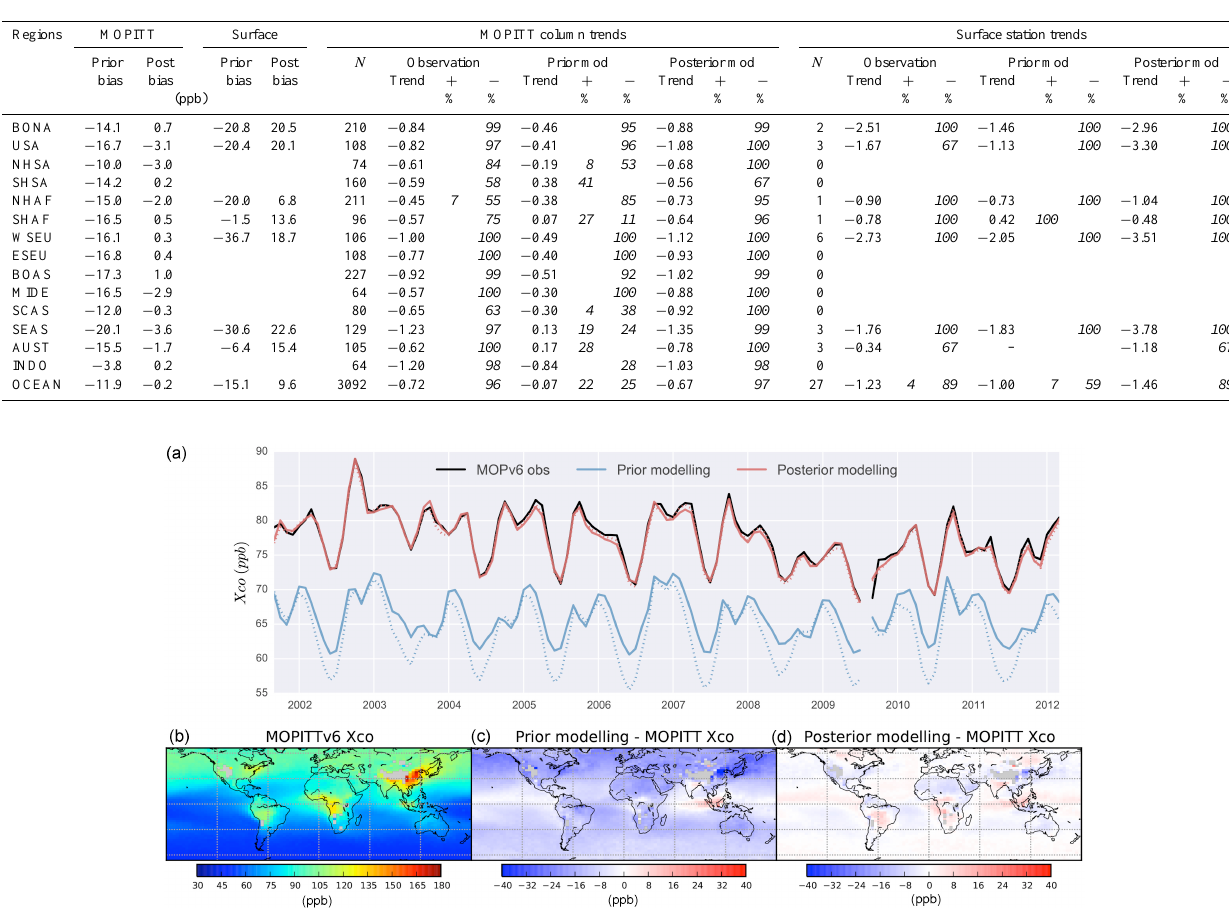
Table 2. Summary of CO model–data comparison and trend analysis for MOPITT satellite retrievals, surface station observations and corresponding prior/posterior modelling. Trends for each region (in the unit of ppbyr − 1 ) are the mean values for all the grids whose trends are significant at the 95% confidence level. The percentages of significant trends (shown in italic) are also given per model grid for positive ( + ) and negative ( − ) respectively.